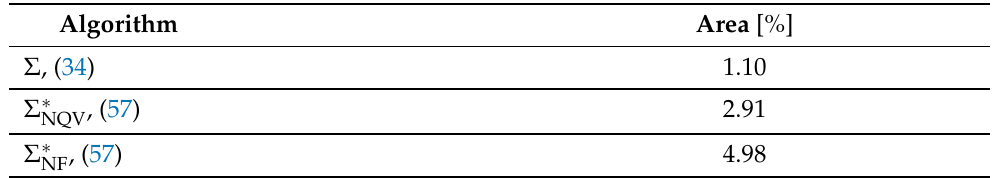
Table 4. Comparison of areas occupied by the basin of attraction sets estimated based on numerical